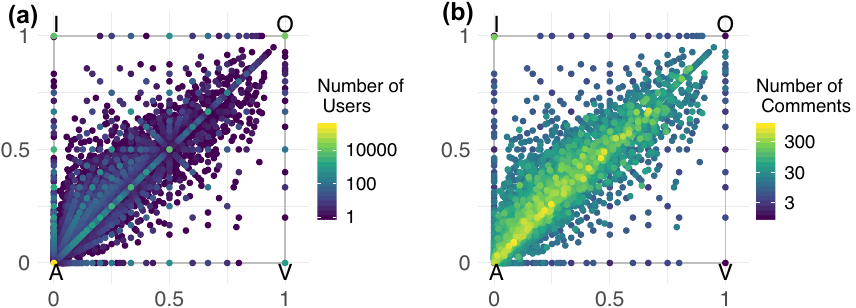
Figure 5. Users balance between different comment types. In panel ( a ) brighter dots indicate a higher density of users while in panel ( b ) brighter dots indicate a higher average activity of the users in terms of number of comments. We note that users focused on posting comments labelled as offensive and violent are almost absent in the